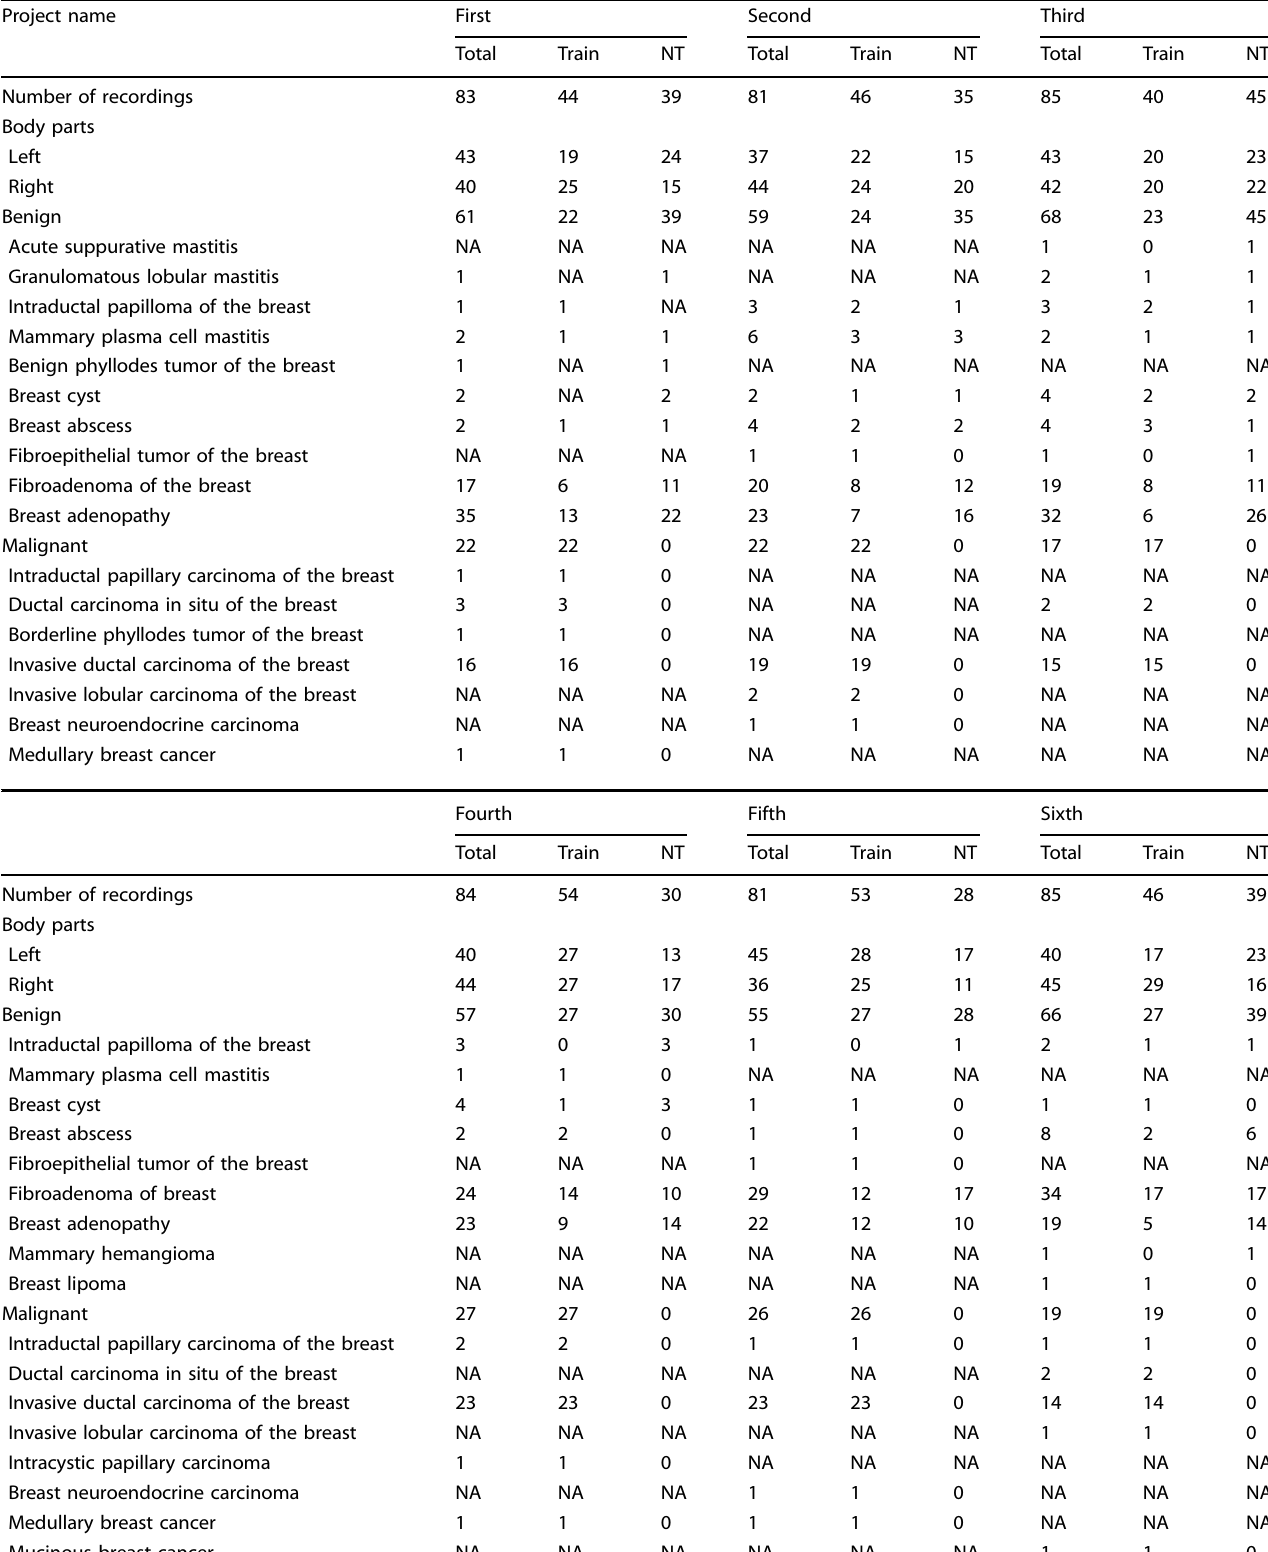
Table 2. Disease distribution and number included in six training